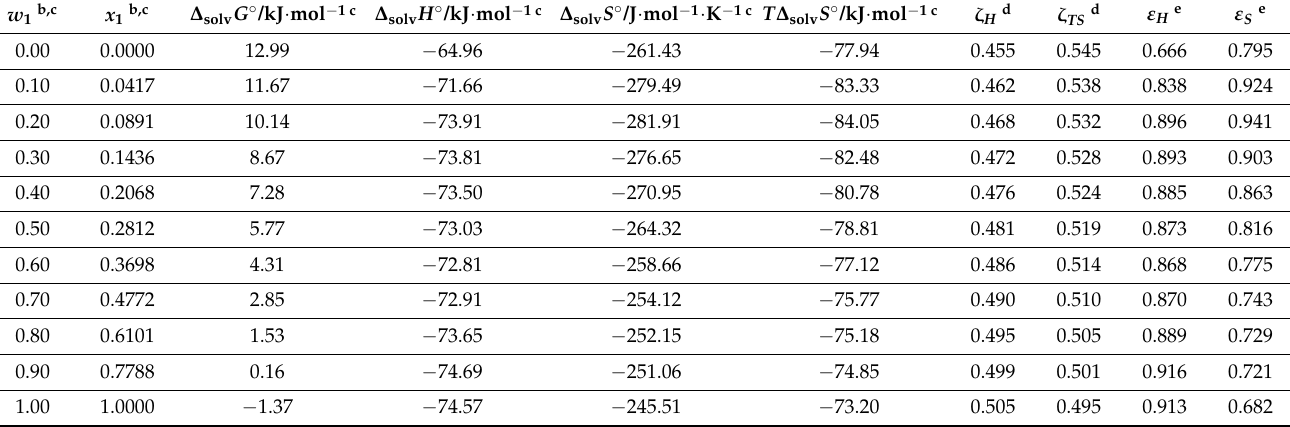
a p is the atmospheric pressure in Aksaray, Turkey. b w 1 and x 1 are the mass and mole fraction of ethanol (1) in the {ethanol (1) + water (2)} mixtures free of benzoic acid (3). c Standard uncertainty in T is u ( T ) = 0.1 K. Standard uncertainty in p is u ( p ) = 3.0 kPa. Mean relative uncertainties in w 1 and x 1 were u ( w 1 ) = 0.0008 and u ( x 1 ) = 0.0008. Average relative standard uncertainty in apparent thermodynamic quantities of mixing processes are u r ( ∆ solv G ◦